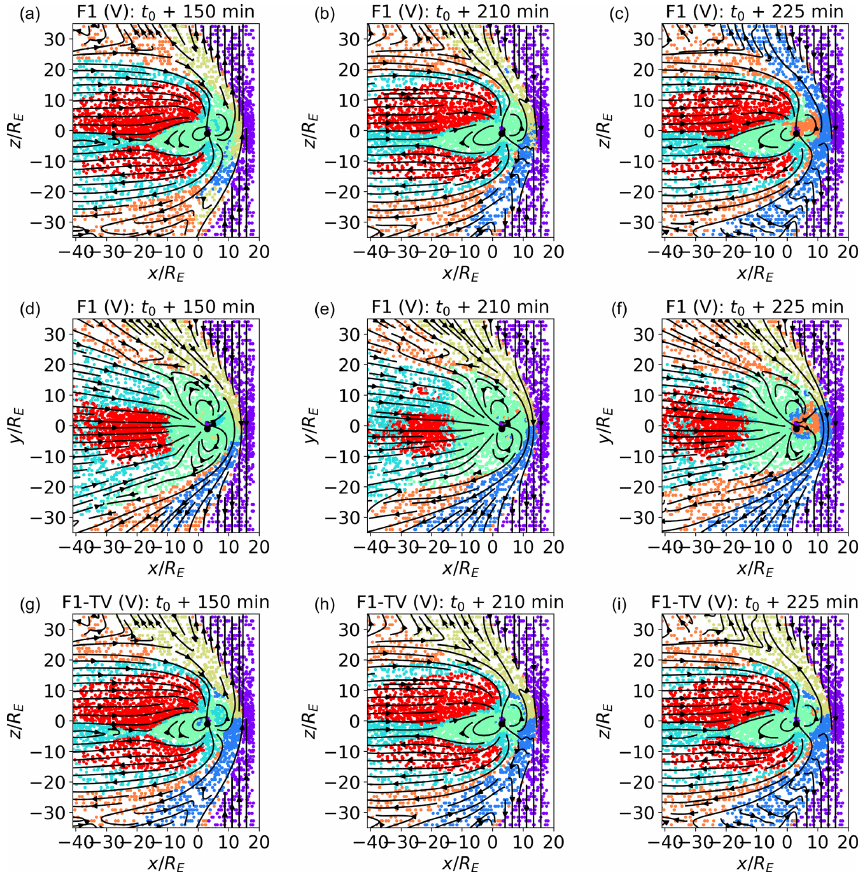
Figure 6. Classification of validation (V) data sets in the meridional (a–c) and equatorial (d to f) planes at t 0 + 150, t 0 + 210, and t 0 + 225min. In panels (a) – (f) , the points are classified with the same classifiers as in Fig. 4. Data points in panels (b) and (e) are from the same simulated time as the training set; those in panels (a) , (c) , (d) , and (f) are from different times. B z points northwards at t 0 + 150min and southwards at t 0 + 210, which is 225min. In panels (g) – (i) , the classifiers are trained with a mixed time data set composed of points from t 0 + 125, 175, and 200min in feature set F1